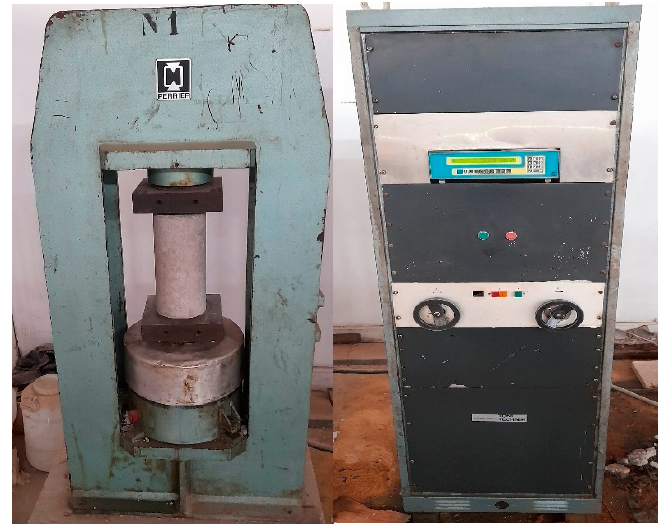
Figure 7. Compressive strength test.